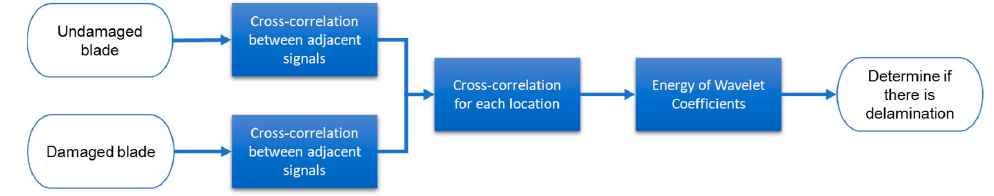
Figure 5. Approach for delamination detection in WTBs.